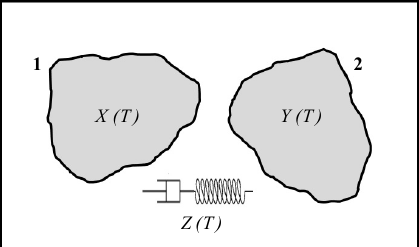
Figure 1. Sketch of the model of a plane fault with two asperities. The rectangular frame is the fault border. The state of the asperities is described by their slip deficits X(T ) and Y(T ) , while the variable Z(T ) represents the temporal variation of the difference between the slip deficits of the asperities due to viscoelastic deformation in the inter-seismic interval following an earthquake on the